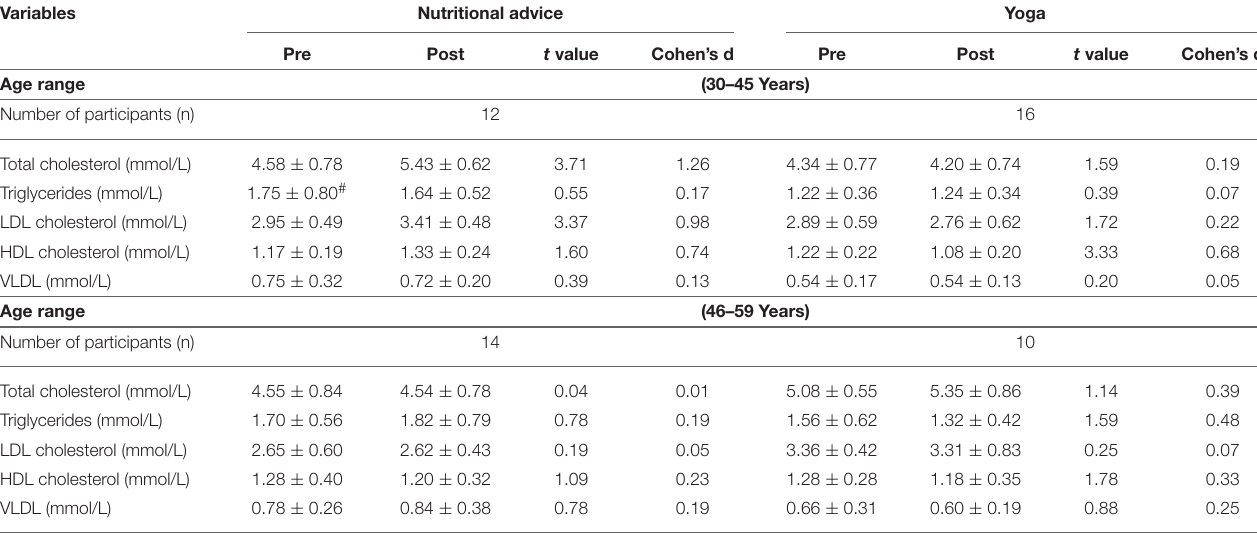
Variables Nutritional advice